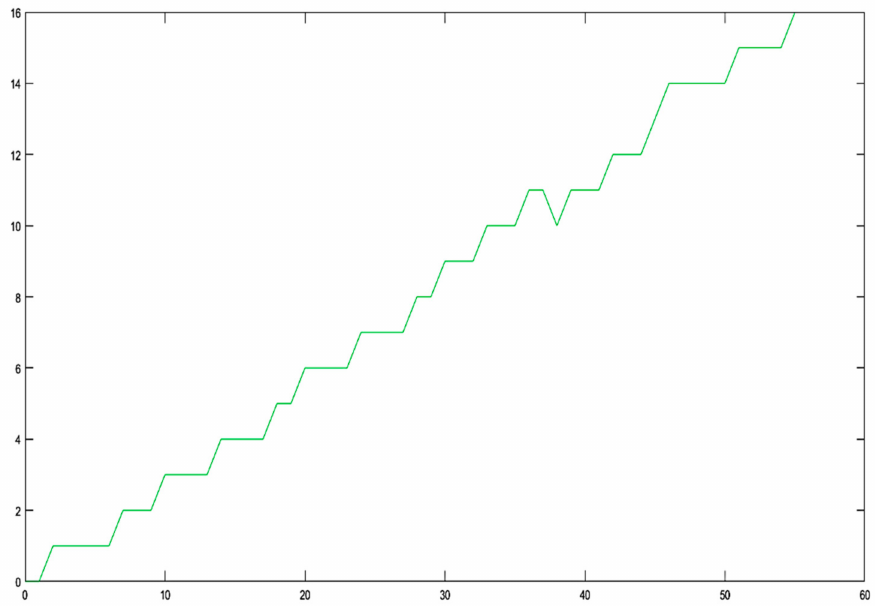
Figure 4. The evolution of the number of the erroneous decimal digits (e. d. d.) accumulated in the power β 2 n , β = 1.12, due to finite precision error. The abscissa represents the recursions’ cardinal number, while y (cid:48) y axis represents the number of e. d. d. Number β has been chosen in such a way, so as inequality | man ( z n − 1 ) · man ( z n − 1 ) | < 10 holds more frequently than the dual one (3.16). As a consequence, the number of e. d. d. grows rapidly, in full accordance with the analysis and the results of Sections 4 and